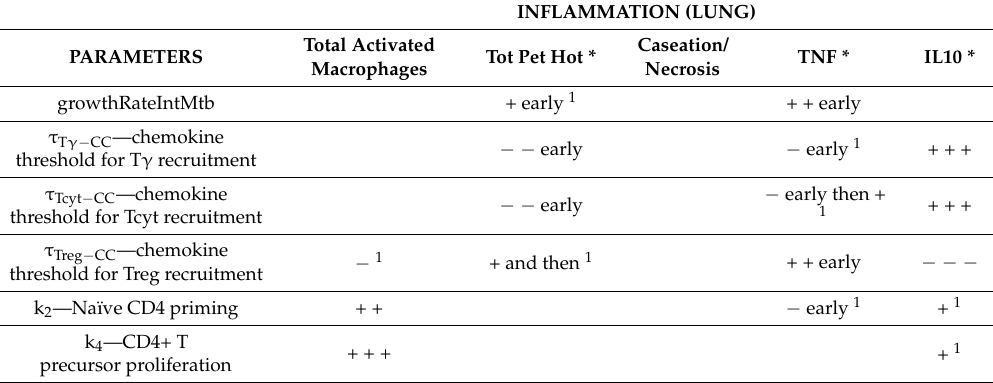
Table 3. Significant PRCCs for inflammation outcomes. List of all the parameters/mechanisms (rows) that have a significant (i.e., p < 10 − 3 ) PRCC with respect to outputs of the model that are directly related to inflammation (columns). See Appendix B for a detailed description of the outcomes analyzed here. A + (or − ) indicates a positive (or negative) correlation between the parameter and the outcome. The magnitude/strength of the correlation is given by the number of + (or − ). The table recapitulates, whenever possible, the dynamics over time. The outputs with * are selected as examples to illustrate PRCC time courses (see Figure 6). See Appendix A for details on the parameters listed below.